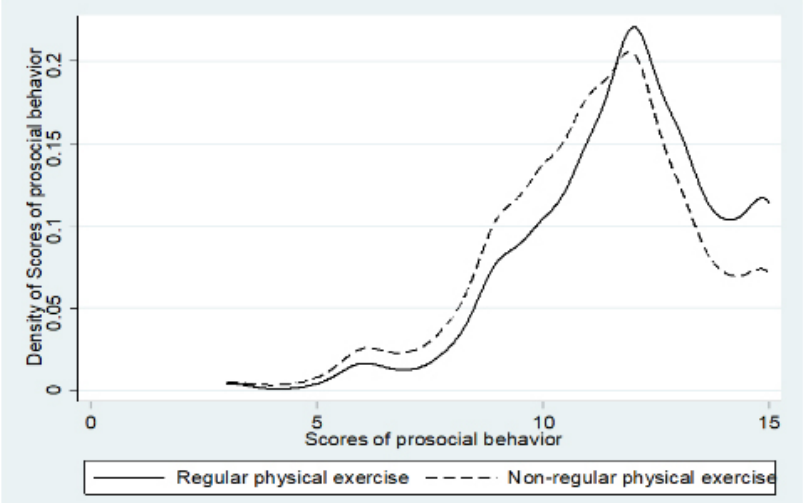
Figure 1. Distribution of prosocial behavior scores with regards to the regular participation in phys- ical exercise.